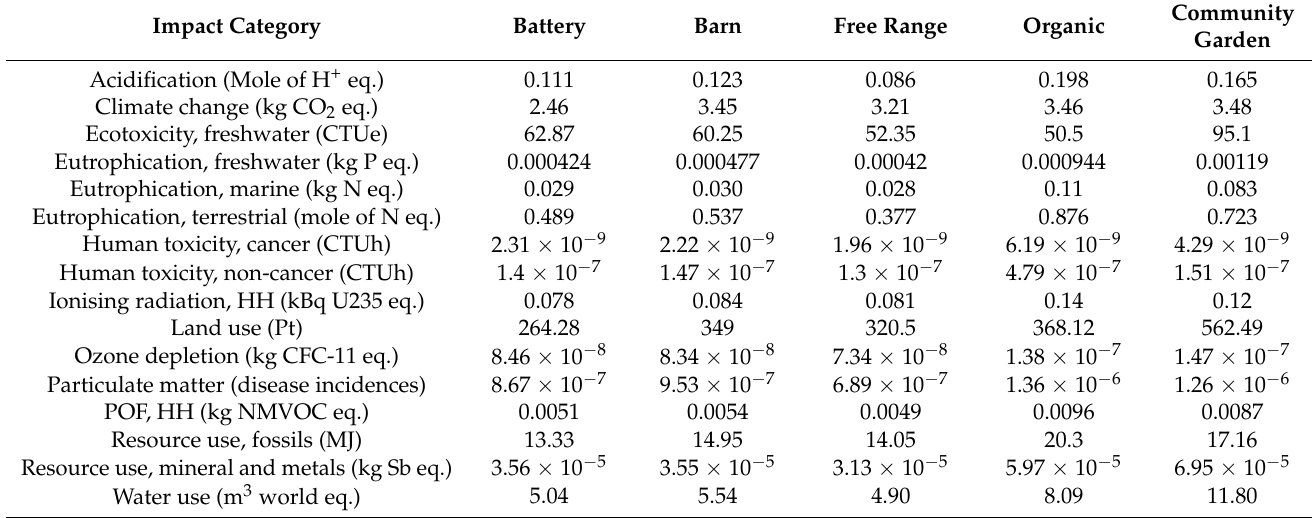
Table 5. Results per impact categories for the production of one kilogram of eggs per laying system in the Czech Republic using Environmental Footprint